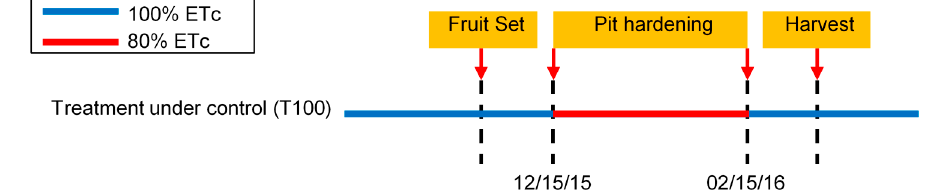
Figure 13. Timestamp diagram for the application of the RDI strategy in the course of the pit-hardening period in cv. Arbequina .